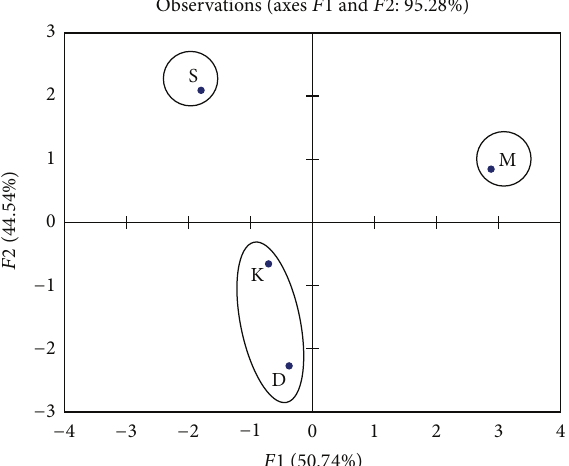
Figure 2: Plots of the 𝑥 -loudings for vitamin contents of okra